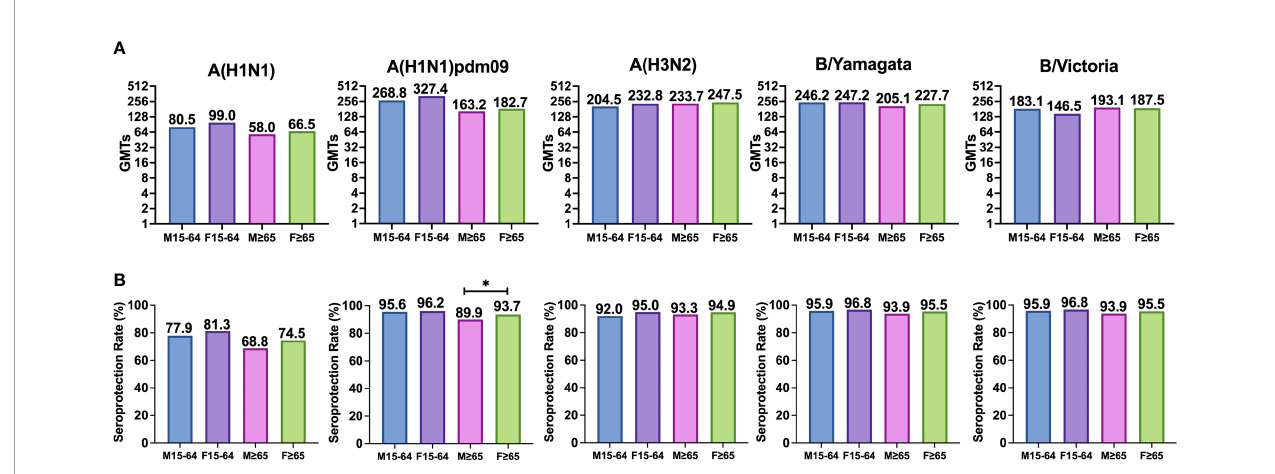
FIGURE 3 | (A) Represents the GMTs and (B) represents the SPR achieved in both cases after vaccination in each group for each subtype. Signi fi cant differences (p<0.05) are marked with